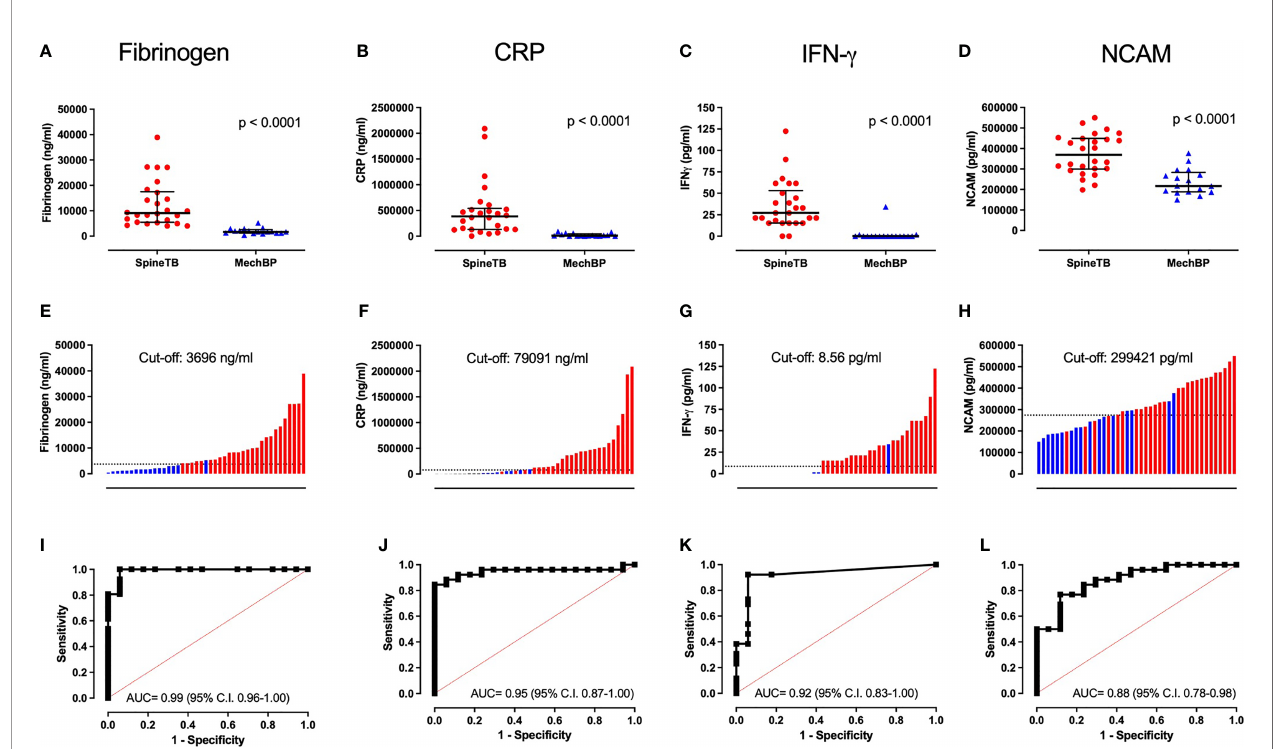
FIGURE 1 | Distribution of individual biomarker levels in spinal TB and mechanical back pain and the utility of biomarkers to distinguish spinal TB. (A – D) show the median and interquartile range of biomarkers within each group and the p-value of a Mann-Whitney U test; (E – H) show the rank order of individual biomarker levels when combining the groups with red bars representing spinal TB, blue bars representing mechanical back pain and the dashed line representing the cut-off biomarker value for optimal sensitivity and speci fi city; (I – L) show Receiver Operating Characteristic plots along with the Area Under the Curve (AUC) and associated 95% con fi dence interval. Representative plots for Fibrinogen, CRP, NCAM and IFN- g are shown, each of which had an AUC ≥ 0.88.